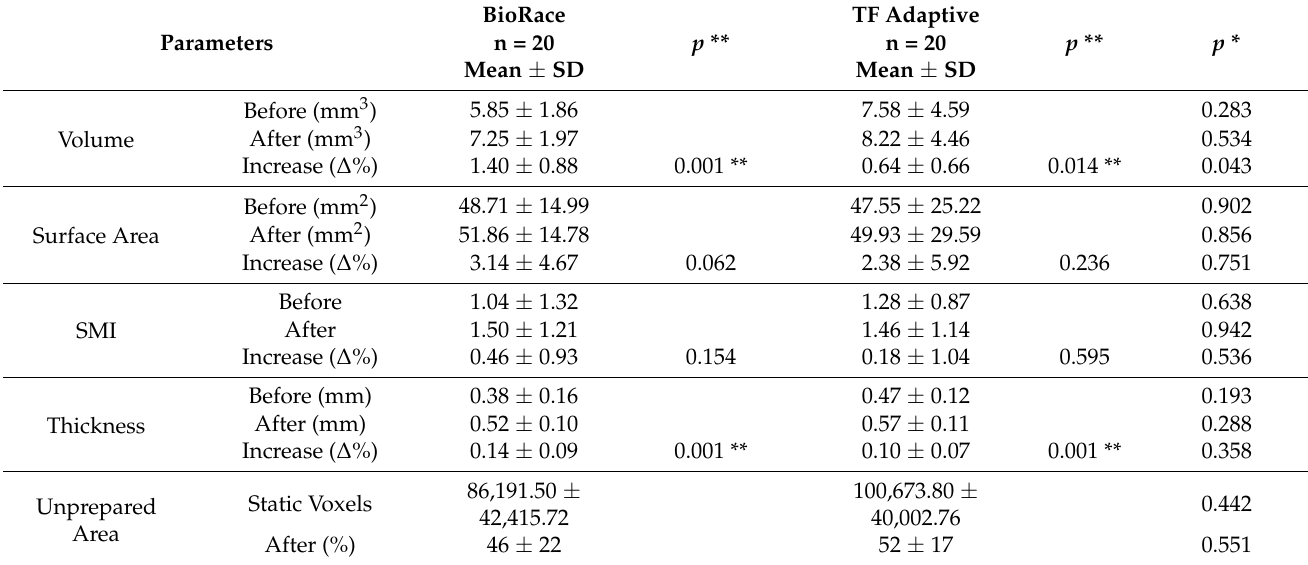
Table 2. Morphometric indices before and after instrumentation of distal canals.